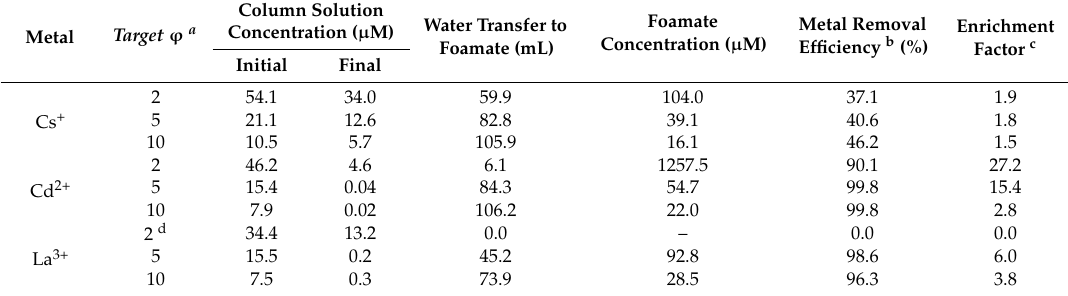
Table 1. Results of ion flotation for Cs + , Cd 2+ , and La 3+ at varying collector-to-colligend ratios in